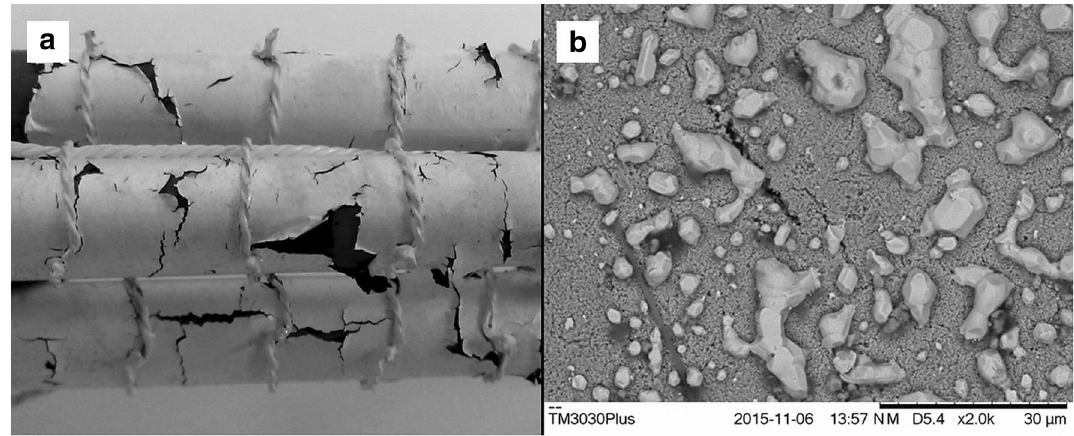
Fig. 7 SEM scans: a cells with cathode exfoliation, b the surface of the Ag-coated cathode, visible crack